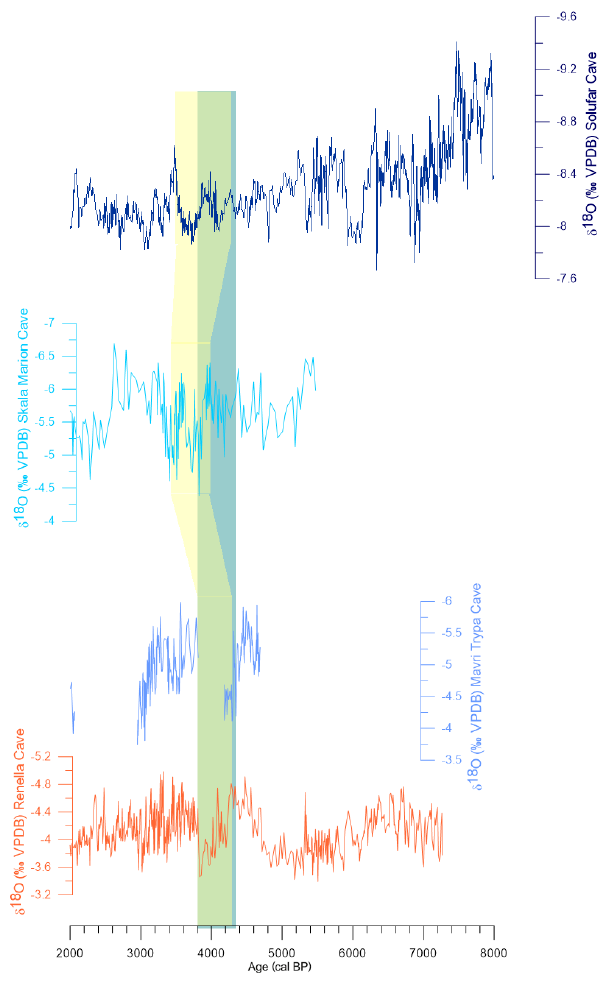
Figure 7. Chronologic approach (green field) and climatostrati- graphic approach (yellow field) applied on speleothem records (based on Psomiadis et al., 2018): Renella Cave (after Zanchetta et al., 2016); Mavri Trypa Cave (after Finné et al., 2017); Skala Mar- ion Cave (after Psomiadis et al., 2018); Solufar Cave (after Göktürk et al.,